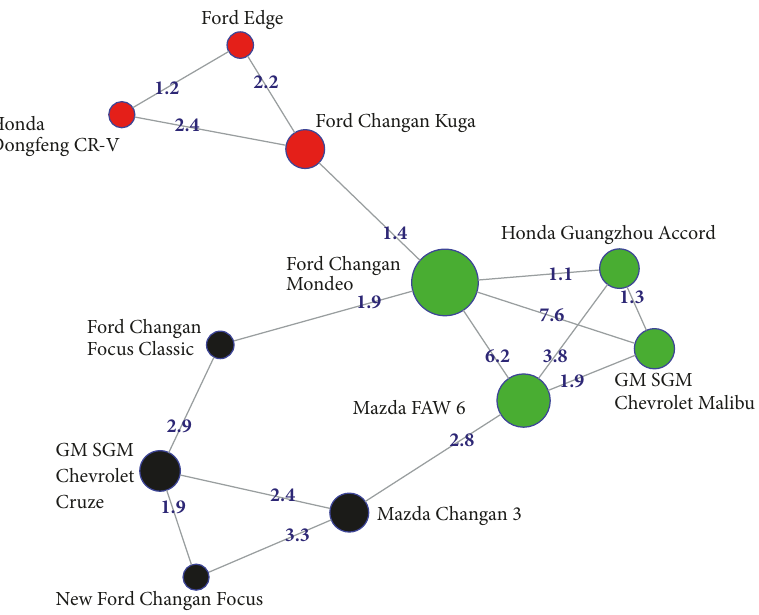
Figure 4: An example of partial vehicle coconsideration network.